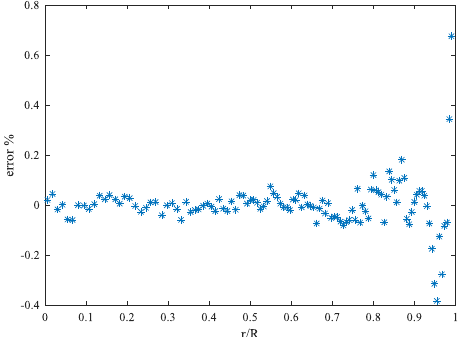
Figure 8. Error in polynomial-fitted data compared to source data ( (cid:15) =1.05)